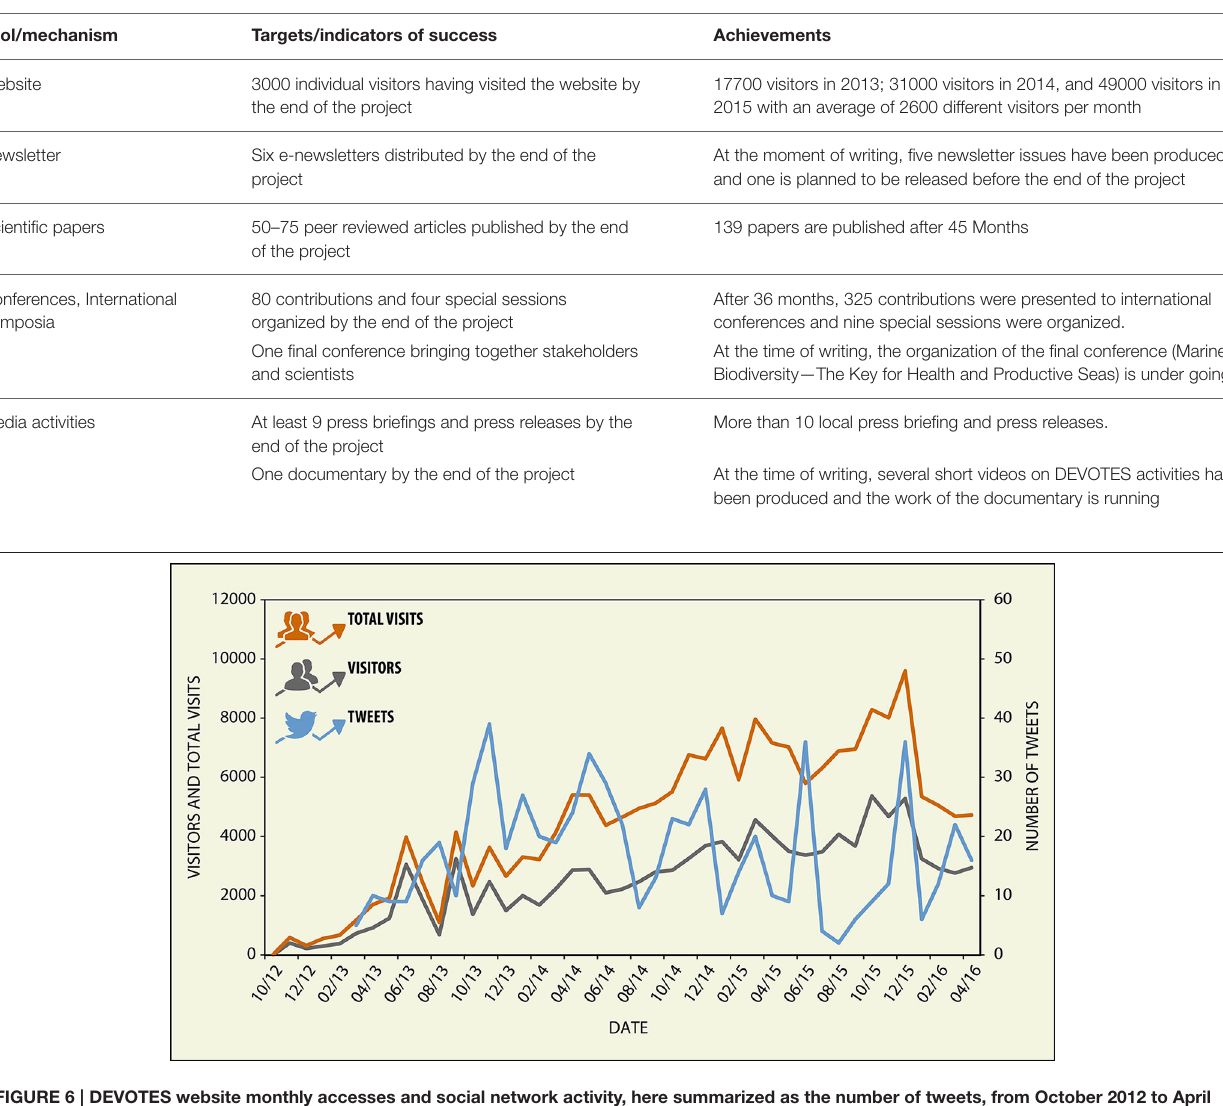
TABLE 1 | Impact targets of the main DEVOTES dissemination